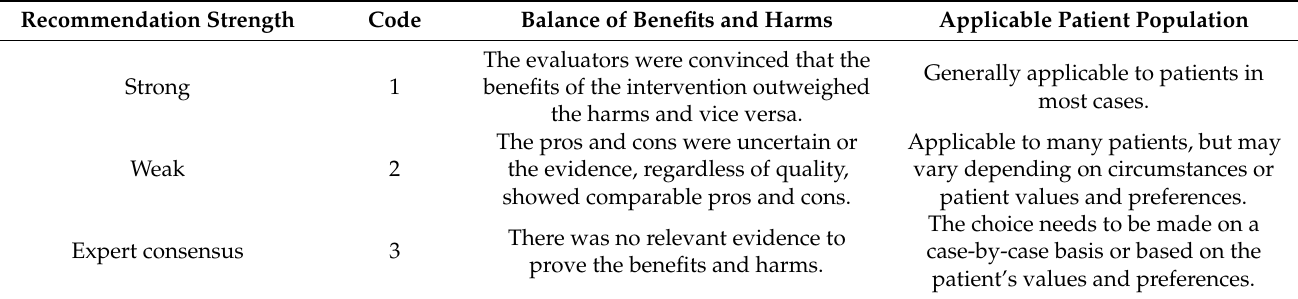
Table 1. Grading of GRADE recommendation